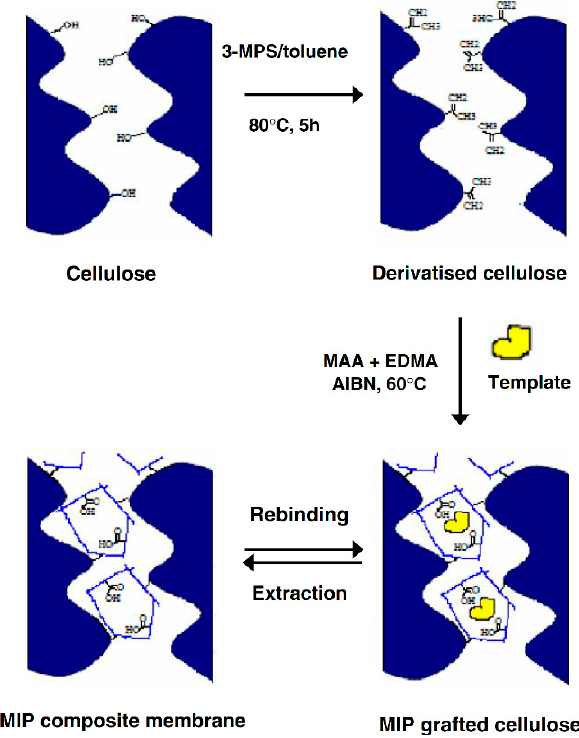
Figure 9. Scheme of cellulose membrane modified with a MIP. Reprinted from [37], Copyright (2022), with permission from Elsevier [or applicable society copyright owner].